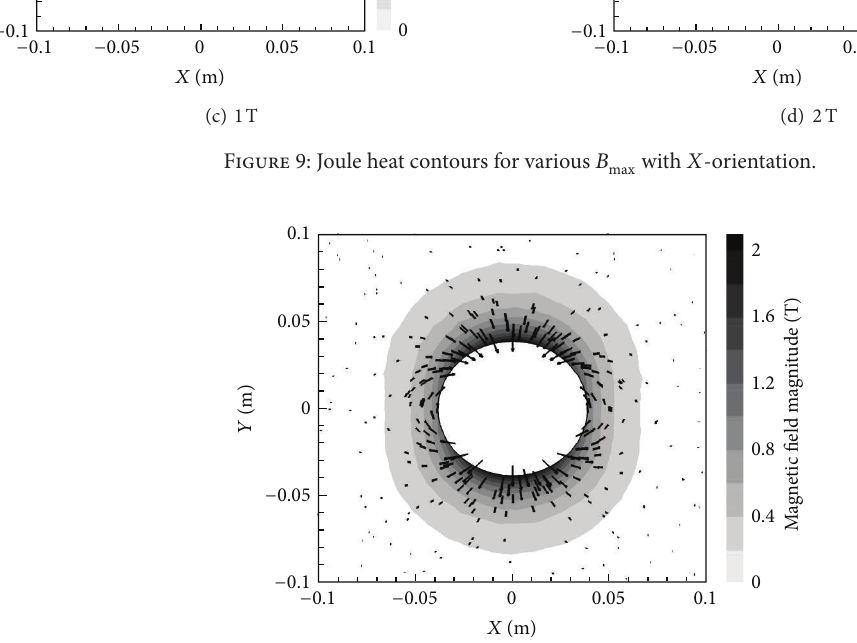
Figure 10: Magnetic field vectors and contours of the magnitude for a 𝑌 -oriented dipole with 𝐵 max = 2